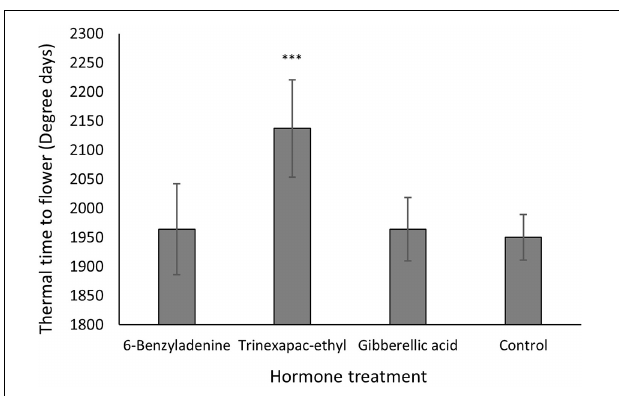
FIGURE 4 | Thermal time to flowering across different hormone treatments from one spray application at GS13 for all varieties under 8 h day lengths. Thermal time data was analyzed by ANOVA in statistical package GENSTAT at the 5% significance level. ∗∗∗ P < 0.001 (different compared to control), where error bars represent one standard error of the mean